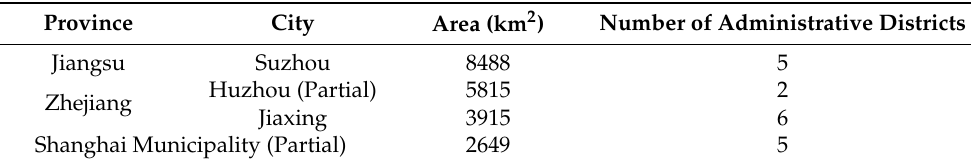
Figure 1. Map of Research Area. Table 1. Administrative information of Study Area.